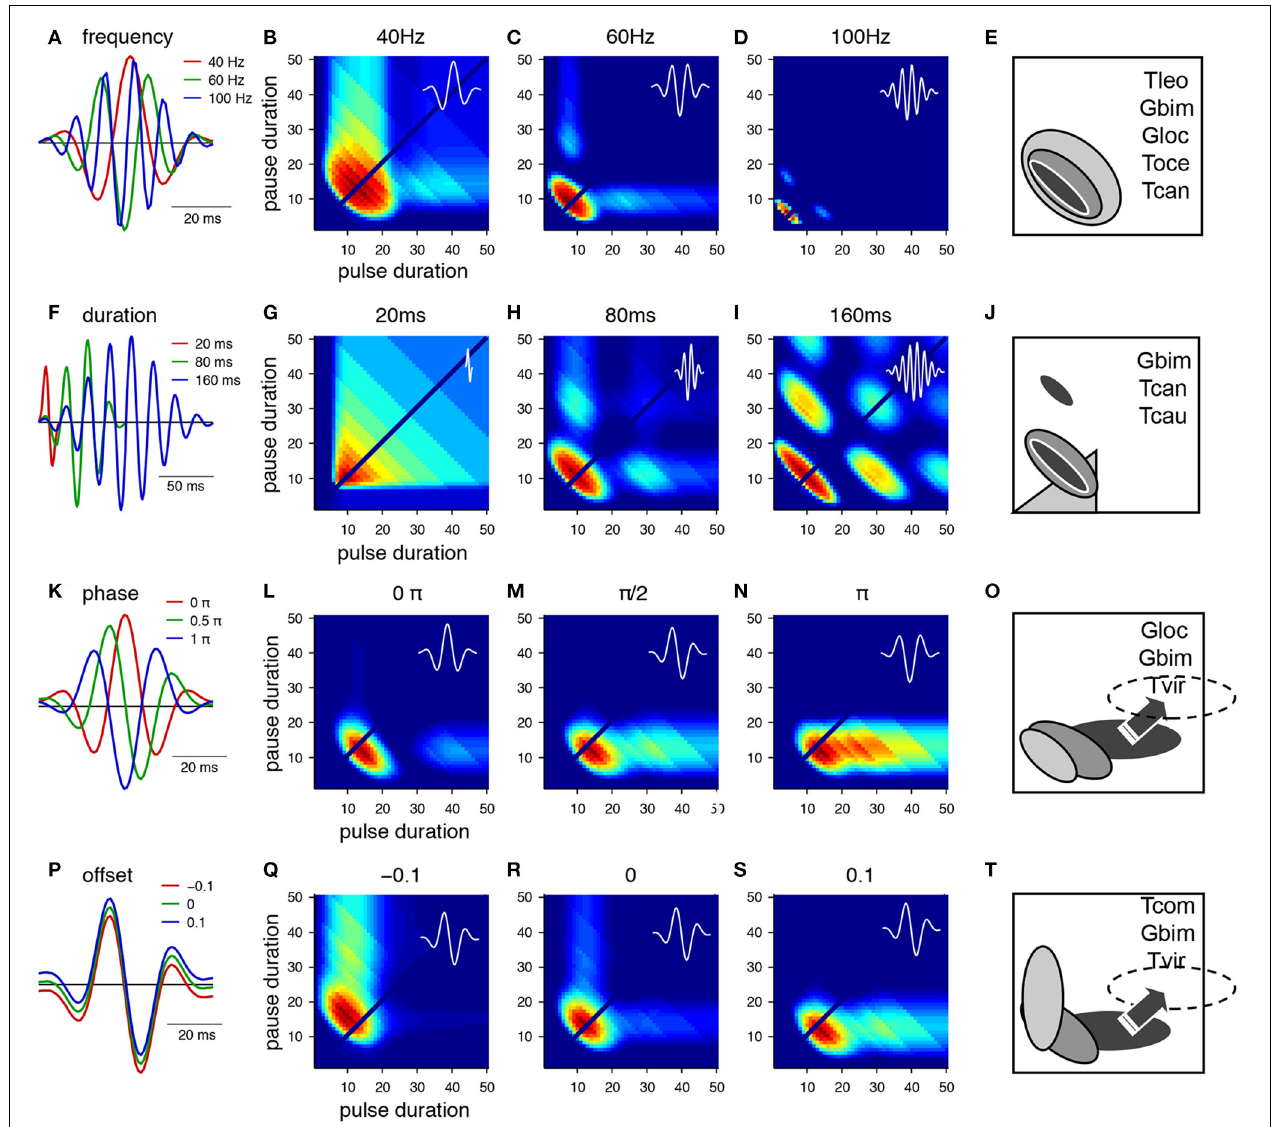
FIGURE 3 | From Gabor filters to behavioral preference functions for a pulse pattern. (A–E) Variation of the frequency and resulting preference profiles. (F–J) Variation of filter duration. (K–O) Variation of phase. (P–T) Variation of offset. Shaded profiles on the right indicate known preference functions for pulse patterns in crickets and katydids. The pulse profile of Tettigonia viridissima , Tvir, was shifted from its original position (see arrow, dashed area). Species: Gbim: Gryllus bimaculatus , Gloc G. locorojo , Tleo Teleogryllus leo , Toce Teleogryllus oceanicus , Tcan Tettigonia cantans , Tcau